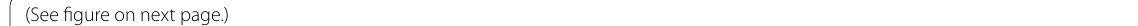
figure on next Fig. 11 Simplified metamorphic map of the SW Alps. Colours refer to both metamorphic grade (in terms of metamorphic facies), and ages. This map is based on Bearth (1962), Bocquet (1971), Bousquet et al. (2004), Michard et al. (2004), Bousquet et al. (2008), Beltrando et al. (2010), Groppo et al. (2019), and our own observations. The distribution of lawsonite (red lozenges) is only shown in the External Briançonnais. Further east, lawsonite becomes widespread in the meta-ophiolites and meta-sediments of the Piemonte-Liguria Ocean (e.g. Caron 1974; Lefeuvre et al. 2020; Vitale Brovarone et al. 2020). Key references for the age of the peak-pressure metamorphism are found in Manzotti et al. (2014) and refs therein for the Sesia-Zone; Rubatto et al. (2008) for the Lanzo peridotites; Monié and Phillipot (1989), Rubatto and Hermann (2003), Rubatto and Angiboust (2015) and Garber et al. (2020) for the Viso; Agard et al. (2002) for the Queyras; and Rubatto and Hermann (2001), Gauthiez-Putallaz et al. (2016) and Chen et al. (2017) for the Brossasco-Isasca Unit. The two studied samples from the Zone Houillère (Guillestre and Briançon) belong to units displaying low-grade parageneses (lawsonite-albite), while their equivalents in the Pinerolo Unit are characterised by garnet-blueschist facies assemblages. Despite identity of the pre-Alpine history i.e. Carboniferous sedimentation (Manzotti et al. 2016) and early Permian magmatism (this study), their fate during the Alpine orogeny is very